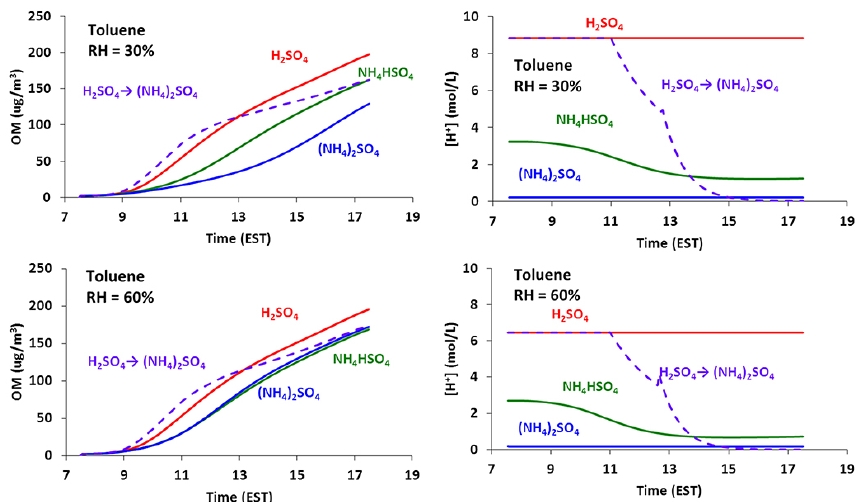
Fig. 5. Time profiles of the simulated OM and aerosol acidity ([H + ], molL − 1 in inorganic aerosol) in four different inorganic aerosols: sulfuric acid (red), ammonium bisulfate (green), ammonium sulfate (blue), and sulfuric acid with ammonia neutralization (violet). To mimic atmospheric conditions in the model simulation, inorganic aerosol (e.g., sulfuric acid, ammonium bisulfate, and ammonium sulfate) is added into the chamber at the constant rate (2.1µgm − 3 h − 1 ). The total amount of inorganic aerosol introduced into the chamber is 20µgm − 3 . For the case of the neutralization of sulfuric acid with ammonia, sulfuric acid is added for the first 3.5h (07:30 to 11:00EST), and ammonia is added to the chamber between 11:00 and 17:30EST. For the model simulation, both the sunlight data and the consumption of toluene employ data on Exp. 6 January 2012 at a constant temperature (298.15K) at 30 and